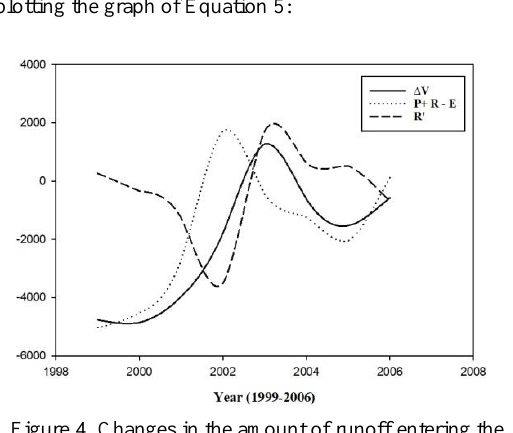
Figure 4. Changes in the amount of runoff entering the Urmia Lake during 1999-2006